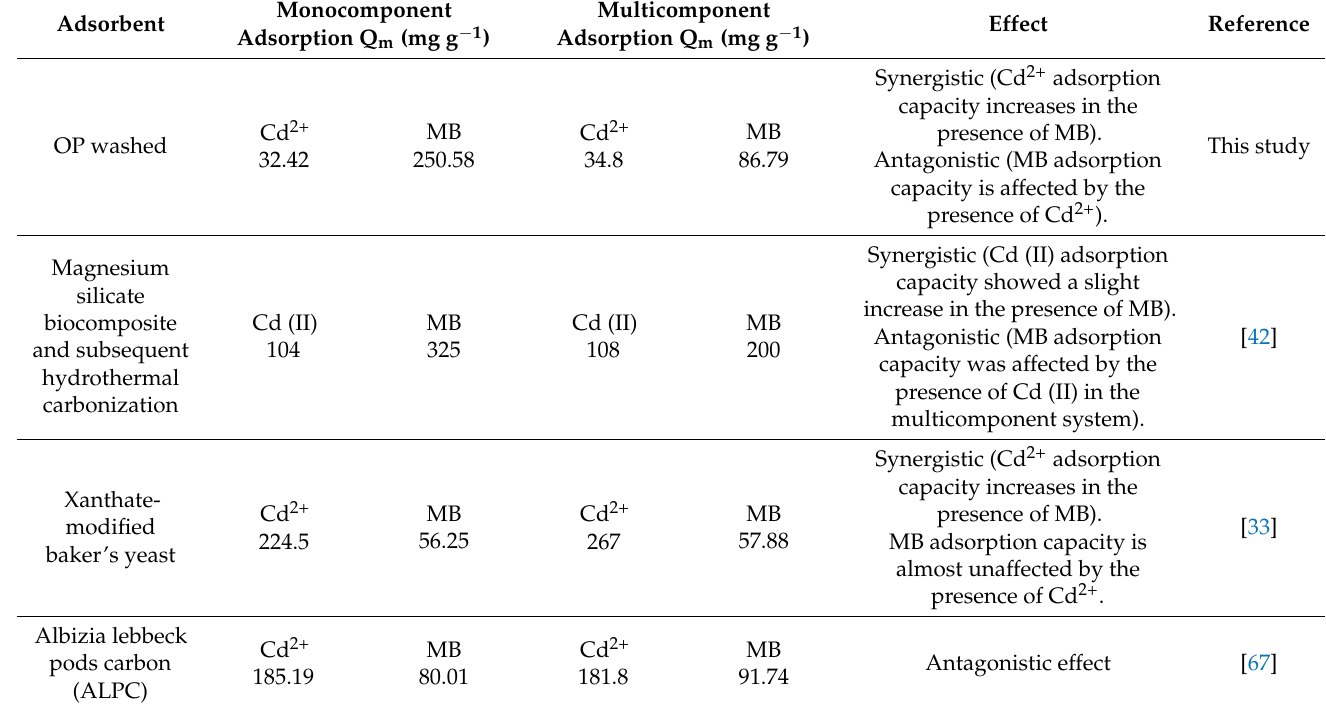
Table 5. Comparison of maximum adsorption capacities of MB and Cd 2+ multicomponent